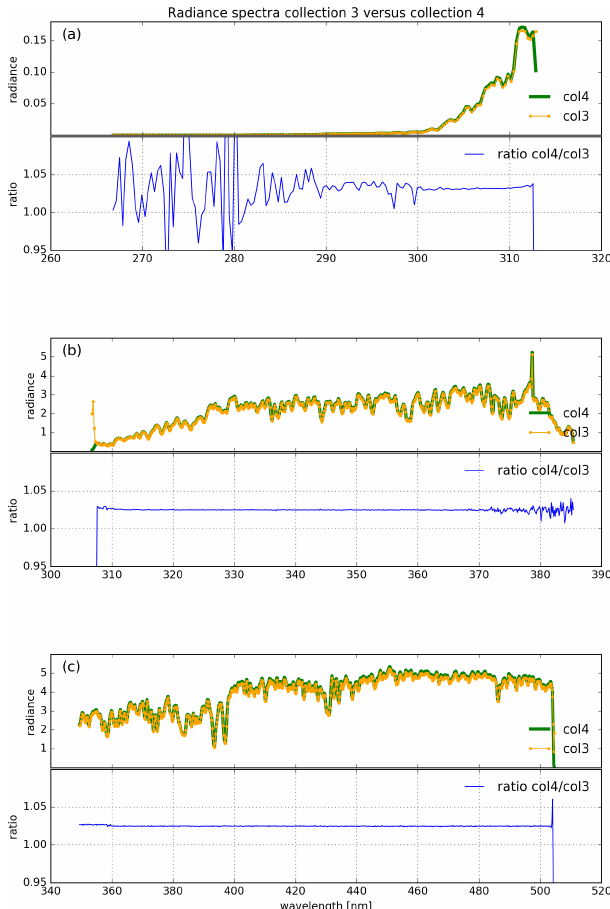
Figure 25. Comparison of the radiance spectra between collection 4 and collection 3 for the UV1 (a) , UV2 (b) , and VIS (c) channels. In each panel the top plot shows both absolute values and the lower plot shows the ratio between the two collections, as observed late in the mission for orbit